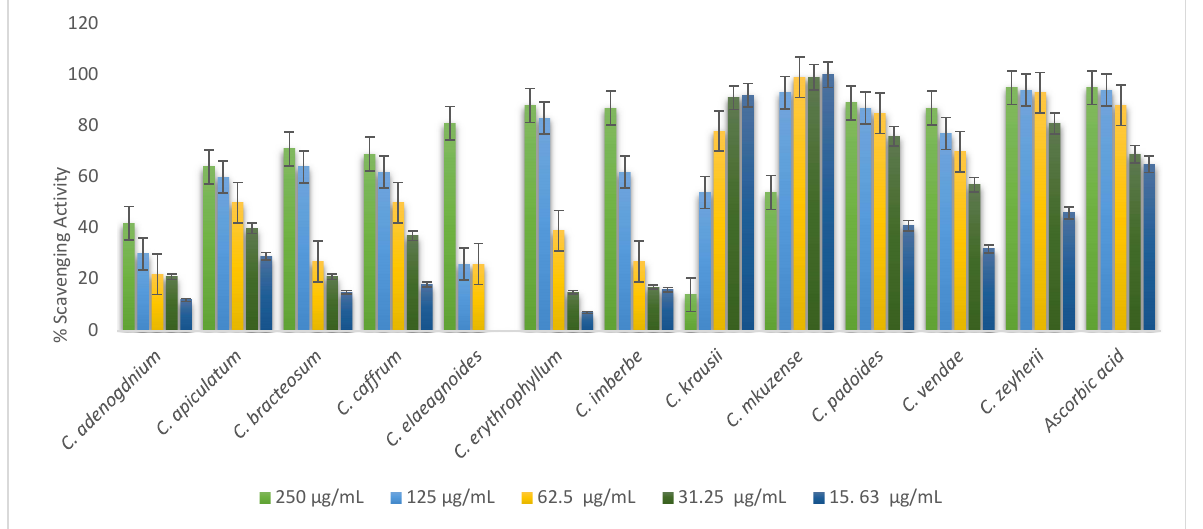
Figure 4. Evaluation of the antioxidant activity of the 70% acetone leaf extracts of the twelve Combretum species.